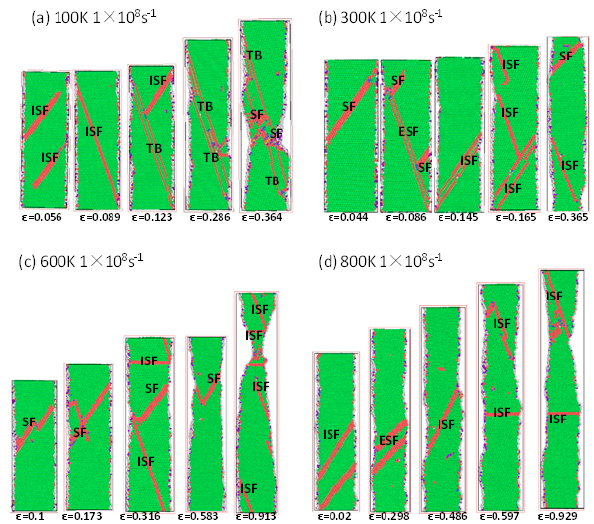
Figure 11. The CNA diagram of GBs HEAs under tensile. ( a ) 100 K, 1 × 10 8 s − 1 ; ( b ) 300 K, 1 × 10 8 s − 1 ; ( c ) 600 K, 1 × 10 8 s − 1 ; ( d ) 800 K, 1 × 10 8 s − 1 .